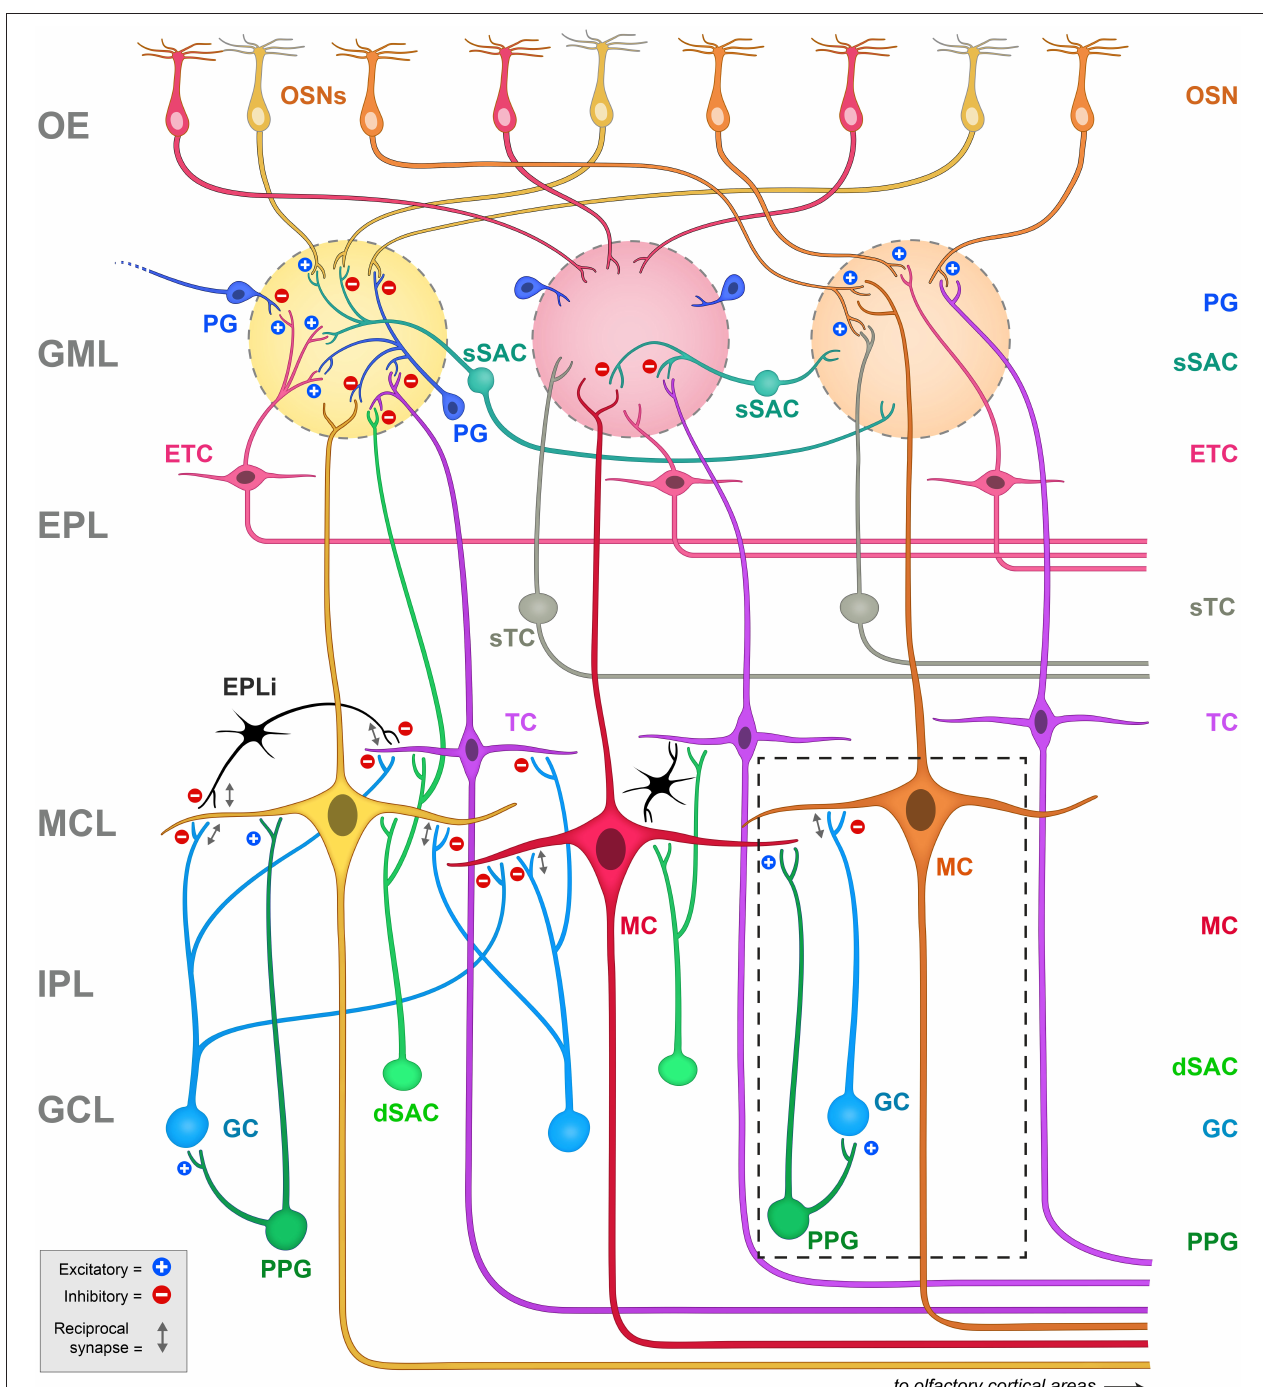
FIGURE 2 | Schematic representation of the principal projection neurons and interneurons in the olfactory bulb, including the synapses between them. Blue plus signs ( + ) represent excitatory synapses, while red minus signs (-) represent inhibitory synapses. Reciprocal synapses are indicated by a gray double arrow. Note the highly laminated organization of the region that has been amendable for physiological and anatomical studies since first explored by Ramon y Cajal. The glomeruli are considered the first sensory processing station along the olfactory pathway where the olfactory signal is transferred from OSNs to glutamatergic output neurons, called mitral (MC) and tufted (TC) cells (Nagayama et al., 2014). Mitral and tufted cells’ axons project to the olfactory cortex and higher order cortical structures conveying the information to the central nervous system (Ghosh et al., 2011; Nagayama et al., 2014). Both mitral and tufted cells (M/TCs) send an apical dendrite into a defined glomerulus, where they establish reciprocal synapses with OSNs and with a heterogeneous population of juxtaglomerular (JG) cells that include